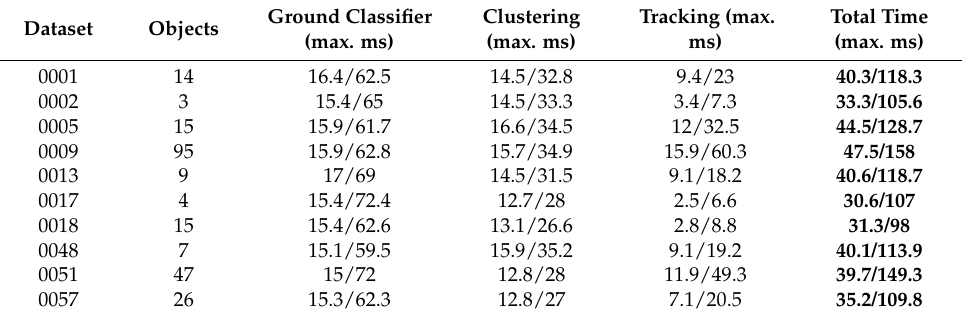
Table 2. Time consumption by main components of MODT on desktop and Jetson board.